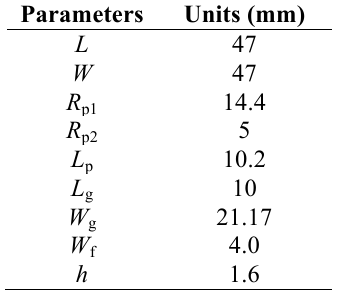
Table 1: Design parameters of the proposed octagonal ring microstrip